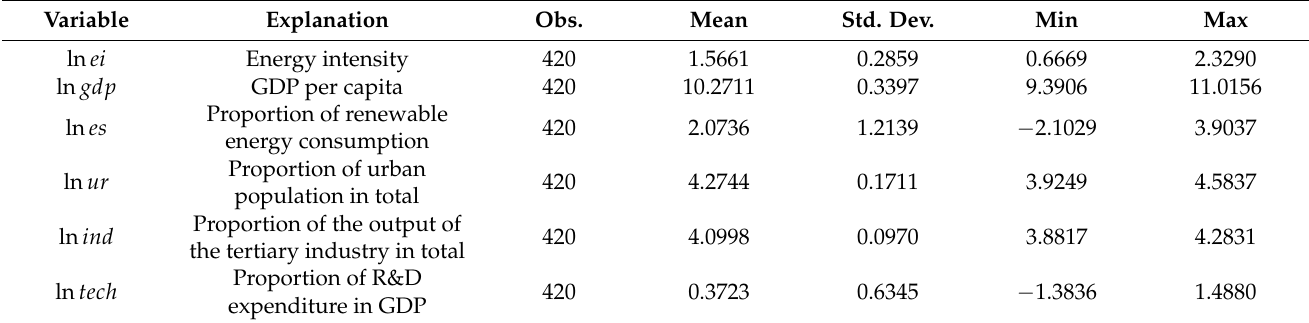
Table 1. Descriptive statistics of the main variables in terms of natural